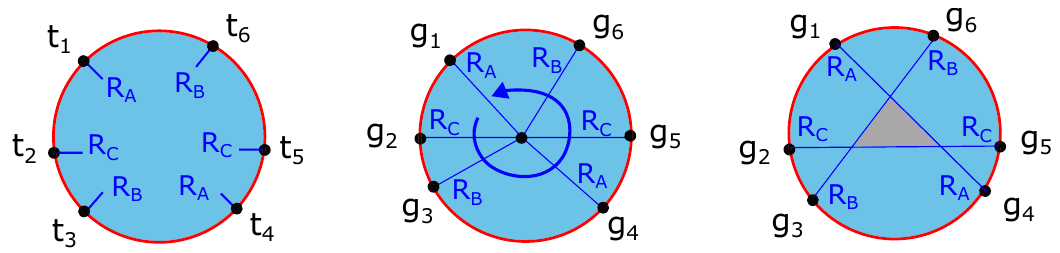
Figure 12 . Left: particle-on-a-group evaluation of a six-point function of three bilocals inserted , i = 1 . . . 6. Middle: Bulk BF angular slicing corresponding to the same computation. at times t i Right: different representation of the same amplitude, where now the bulk BF diagram contains an enclosed region that does not know about the coset